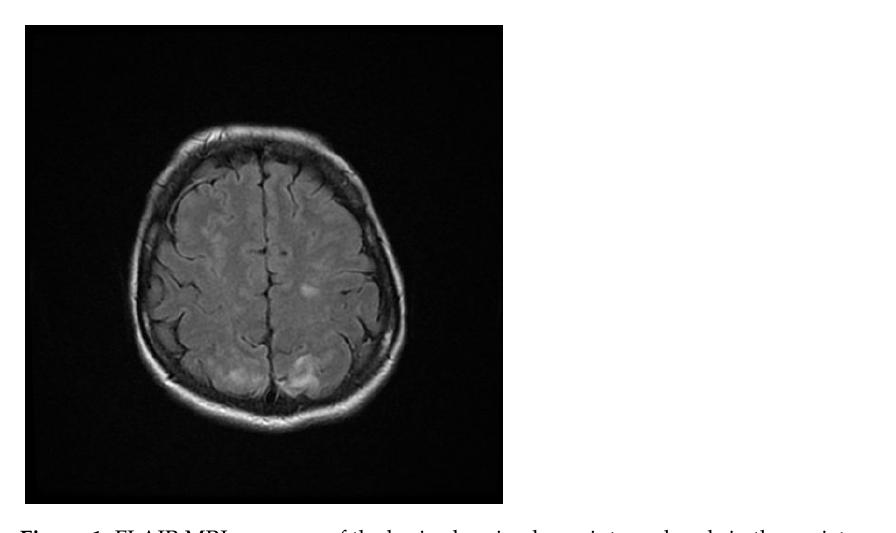
Figure 1. FLAIR MRI sequence of the brain showing hyperintense bands in the parieto-occipital areas on both sides.